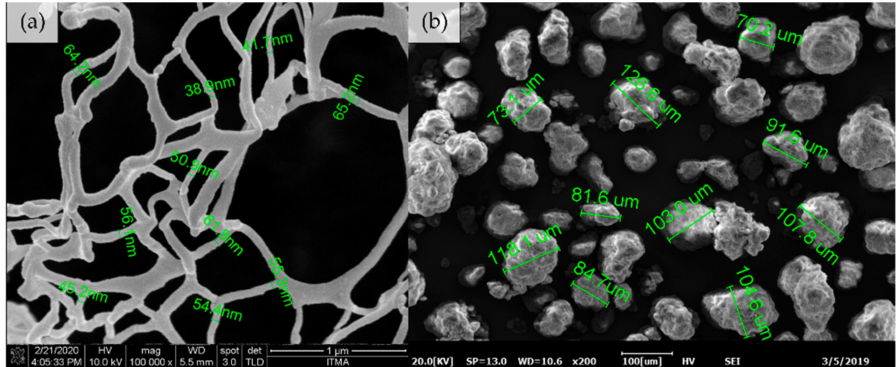
Figure 4. Scanning electron microscope images of ( a ) CNF and ( b )